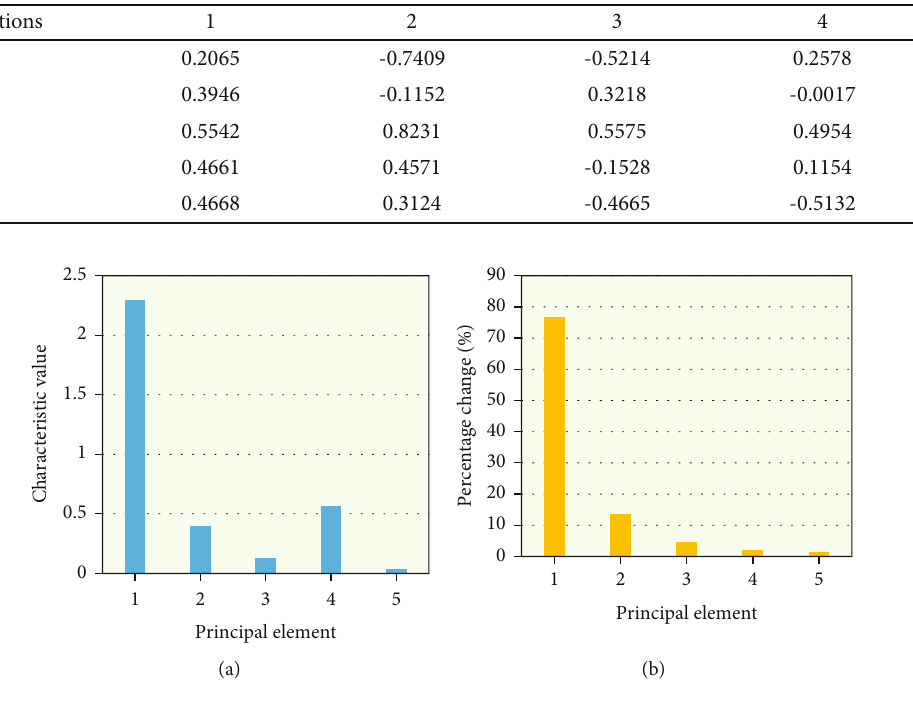
Figure 6: Similarity measurement. Table 1: PCA.